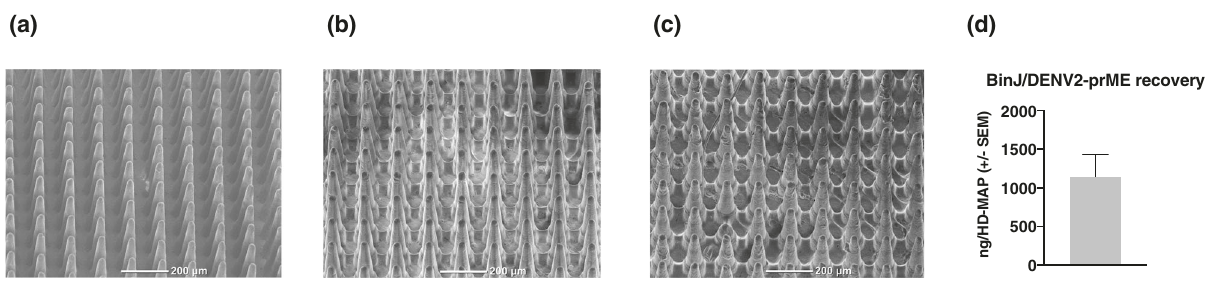
Fig. 4 SEM images and delivery ef fi ciency of BinJV/DENV2-prME-coated HD-MAP. SEM images of a an uncoated HD-MAP, b HD-MAP coated with BinJ/DENV2-prME and c HD-MAP post application, showing the removal of vaccine from the tips of the projections. d Vaccine dosage delivered by HD-MAPs were evaluated prior to immunization. Subtractive ELISA using antibodies against the E protein of DENV was performed to determine dose delivered. The bar graph represents the mean of BinJ/DENV2-prME ( n = 5) delivered by HD-MAPs with error bars indicating SEM.